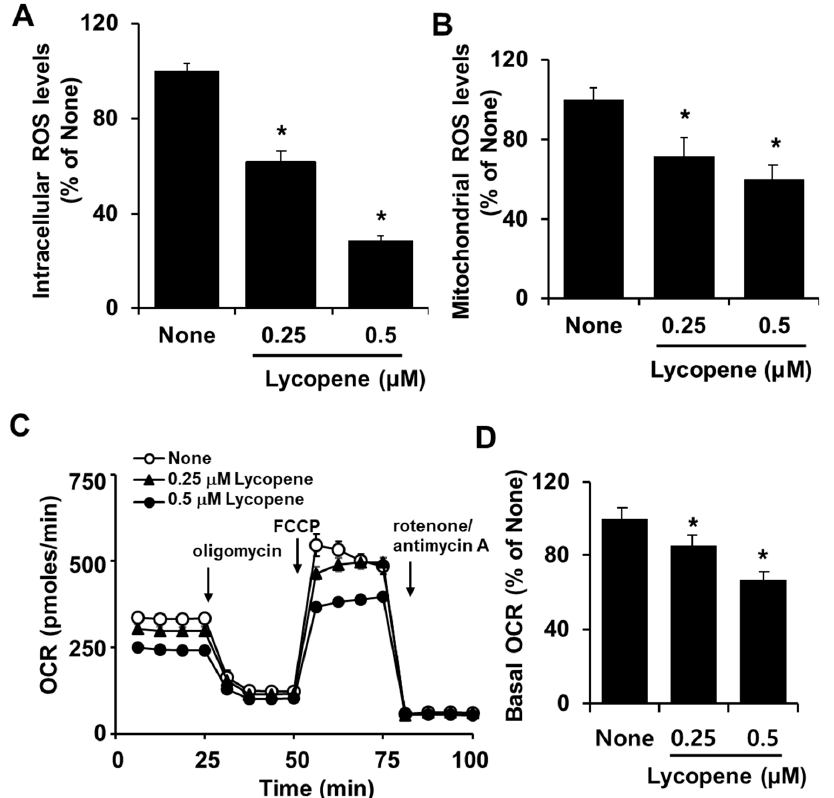
Figure 2. Lycopene decreased intracellular and mitochondrial reactive oxygen species (ROS) levels and oxygen consumption rate (OCR) in PANC-1 cells. Cells were treated with the indicated concentrations of lycopene for 24 h. ( A , B ) Intracellular and mitochondrial ROS levels were determined using dichlorofluorescein diacetate (DCF-DA) and MitoSoX, respectively. * p < 0.05 vs. the corresponding “None”. “None” corresponds to the untreated cells; “0.25” and “0.5” correspond to the cells treated with 0.25 and 0.5 µ M lycopene, respectively. ( C ) The Seahorse XF96 analyzer was employed to assess OCR. Real-time analysis of OCR was assessed by perturbing cells with metabolic modulators (oligomycin, FCCP, rotenone and antimycin A). ( D ) Basal OCR was expressed as % of None. OCR for “None” was set at 100. * p < 0.05. Designations of the columns are the same as in ( A